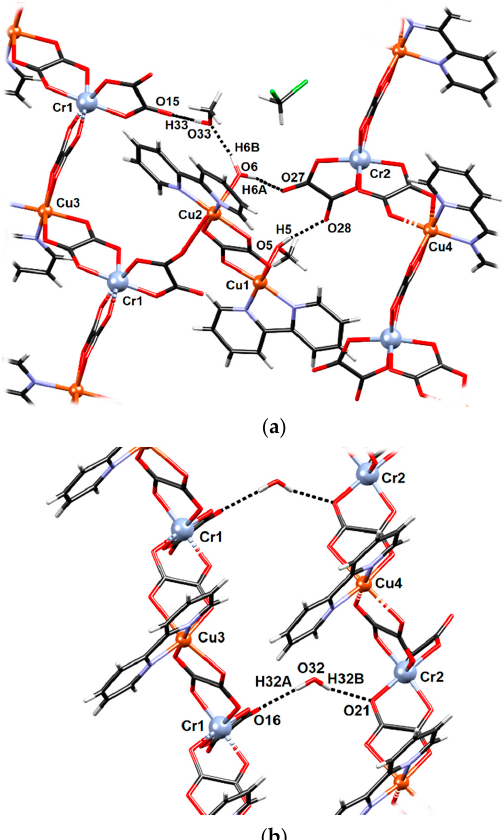
Figure 3. Hydrogen-bonding patterns in 2 : ( a ) dimeric unit Cu1–Cu2 and an uncoordinated methanol molecule connecting two polymeric chains and ( b ) uncoordinated water molecule connecting the Cr1–Cu3 and Cr2–Cu4 chains.